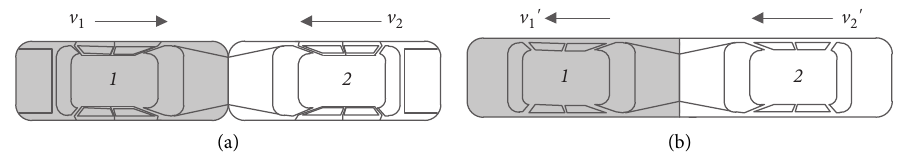
Figure 23: Head-to-head collision. (a) Before head-to-head collision. (b) After head-to-head collision.